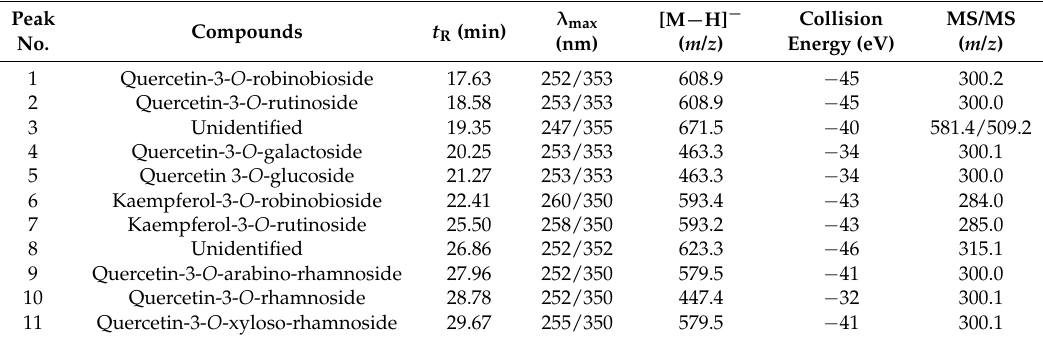
Table 1. Flavonoids identified by liquid chromatography–mass spectrometry/ mass spectrometry (LC-MS/MS) in flavonoids from ZJF.